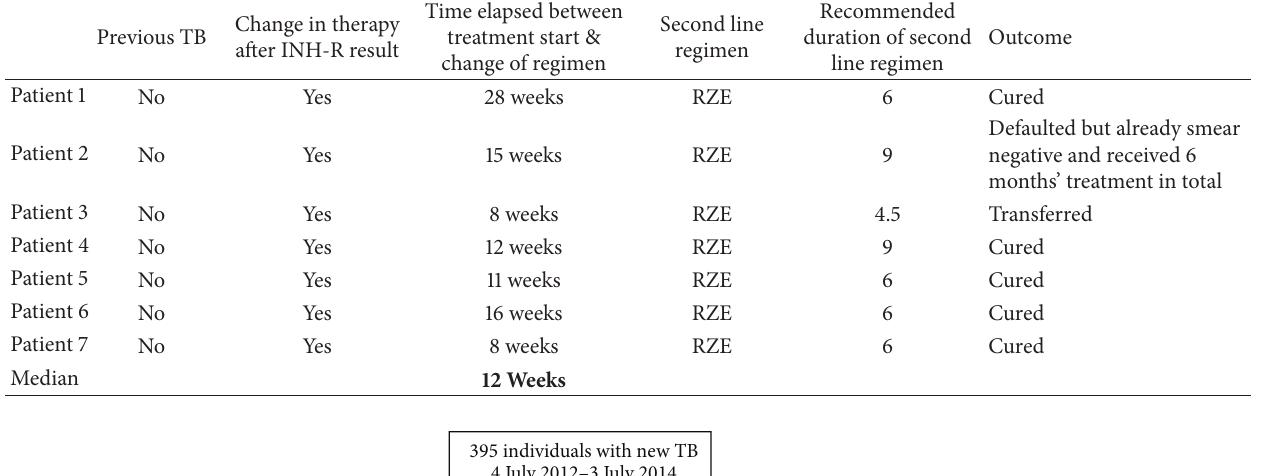
Table 3: Isoniazid resistance among outpatients with pulmonary tuberculosis.